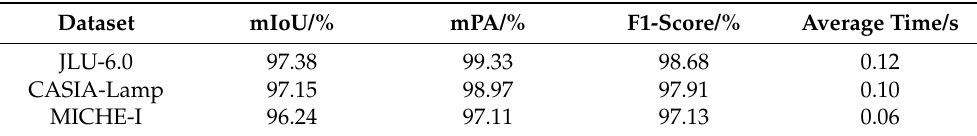
Figure 10. The segmentation results of PFSegIris on the JLU-6.0, CASIA-Iris-Lamp-v4, and MICHE-I test sets, respectively: ( a ) original images; ( b ) ground truth; ( c ) segmentation results; ( d ) merged images. Table 3. The evaluation indexes of PFSegIris on the JLU-6.0, CASIA-Iris-Lamp-v4, and MICHE-I test sets,